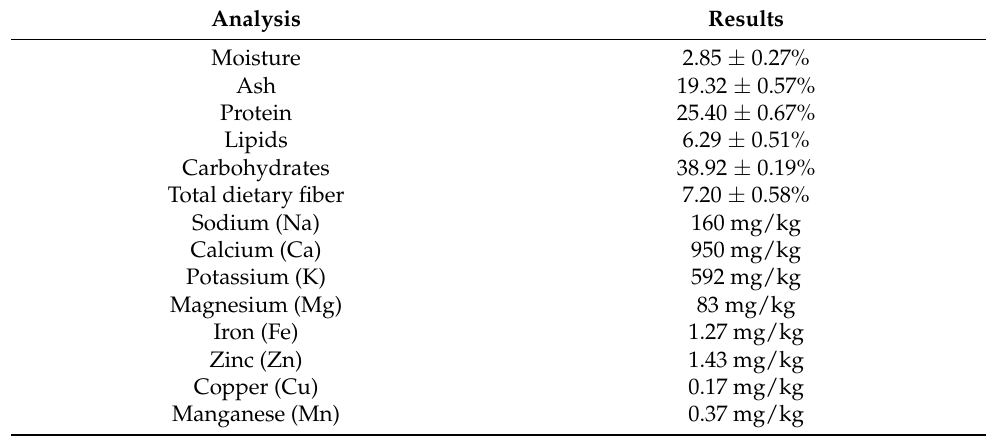
Table 1. Proximate analysis and mineral composition of the lyophilized liquor produced from fermented shrimp